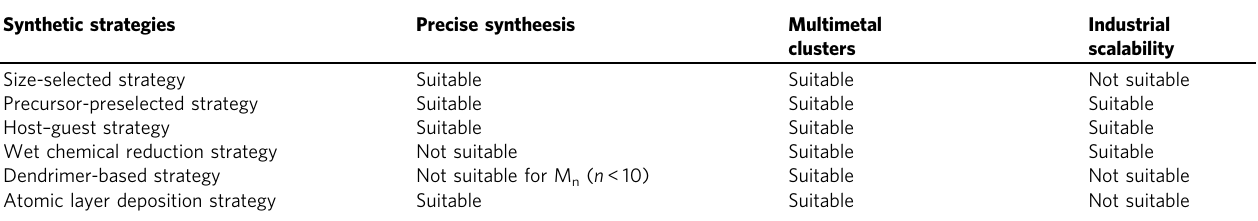
Table 1 Comparison of six synthesis strategies in terms of precision synthesis, multilateral clusters, and industrial